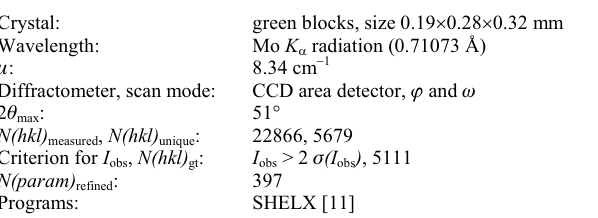
Table 1. Data collection and